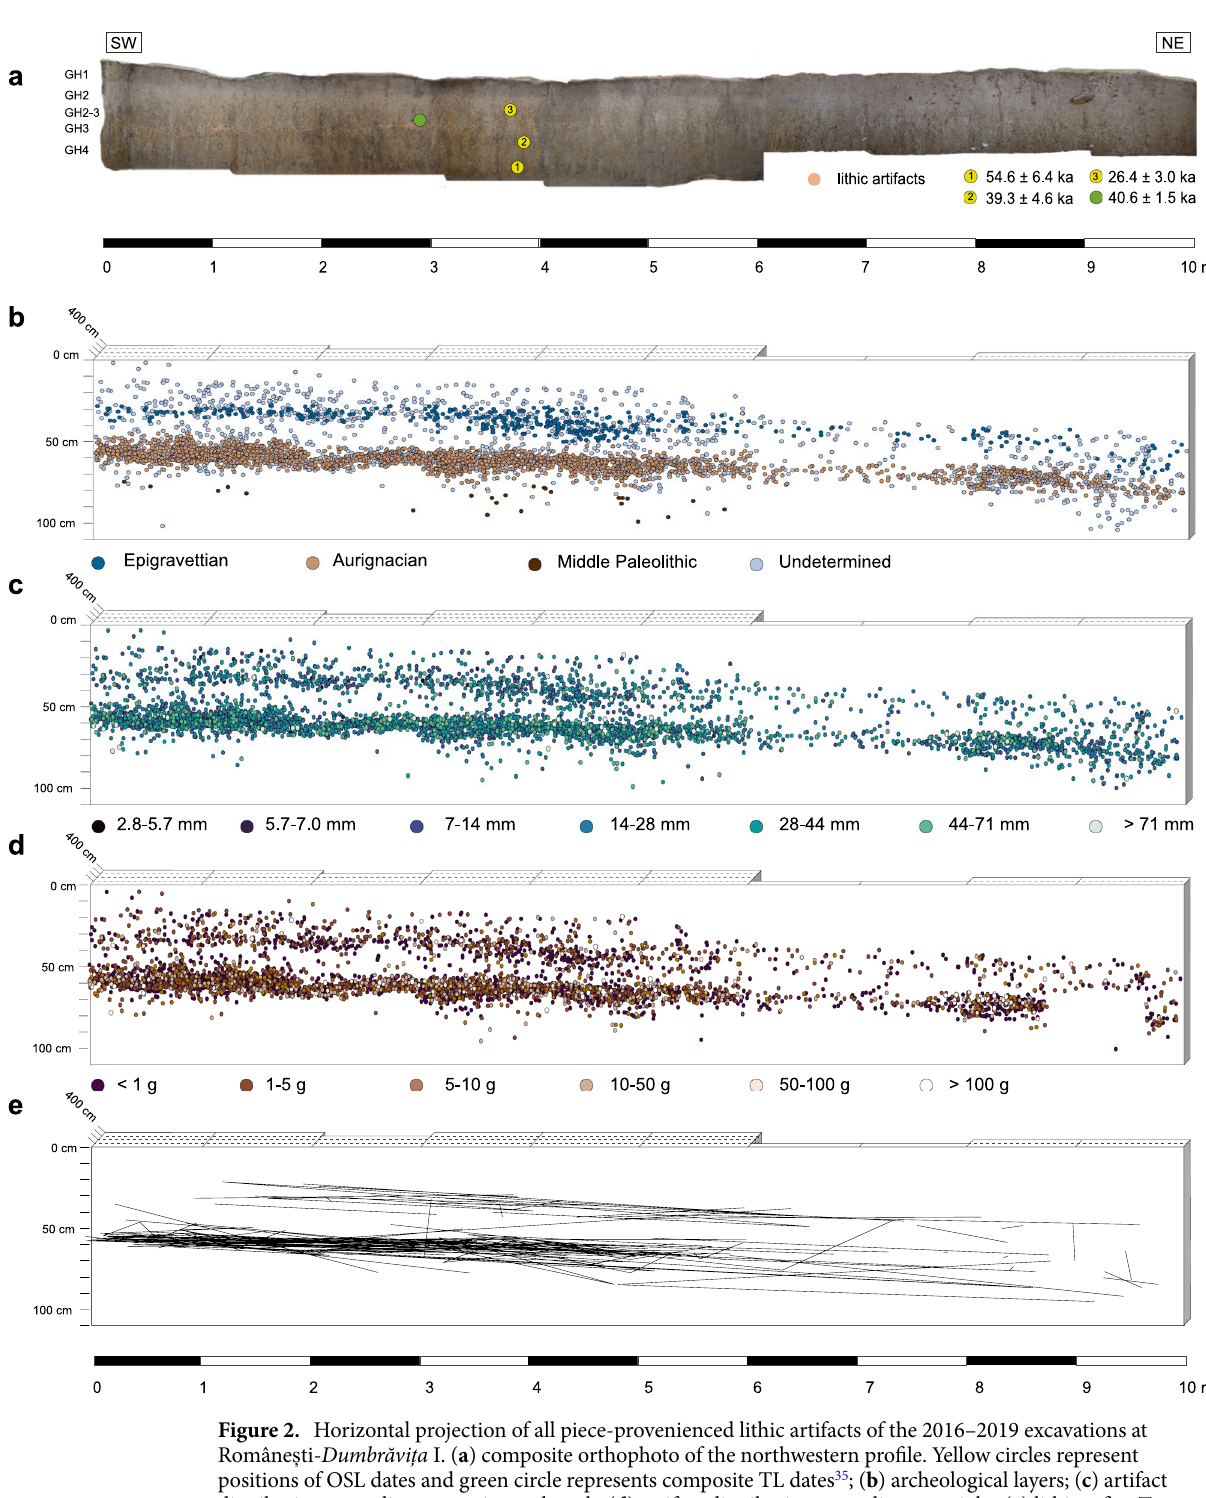
Figure 2. Horizontal projection of all piece-provenienced lithic artifacts of the 2016–2019 excavations at Române ș ti- Dumbrăvi ț a I. ( a ) composite orthophoto of the northwestern profile. Yellow circles represent positions of OSL dates and green circle represents composite TL dates 35 ; ( b ) archeological layers; ( c ) artifact distribution according to maximum length; ( d ) artifact distribution according to weight; ( e ) lithic refits. Top scales in b – e indicates horizontal depth of